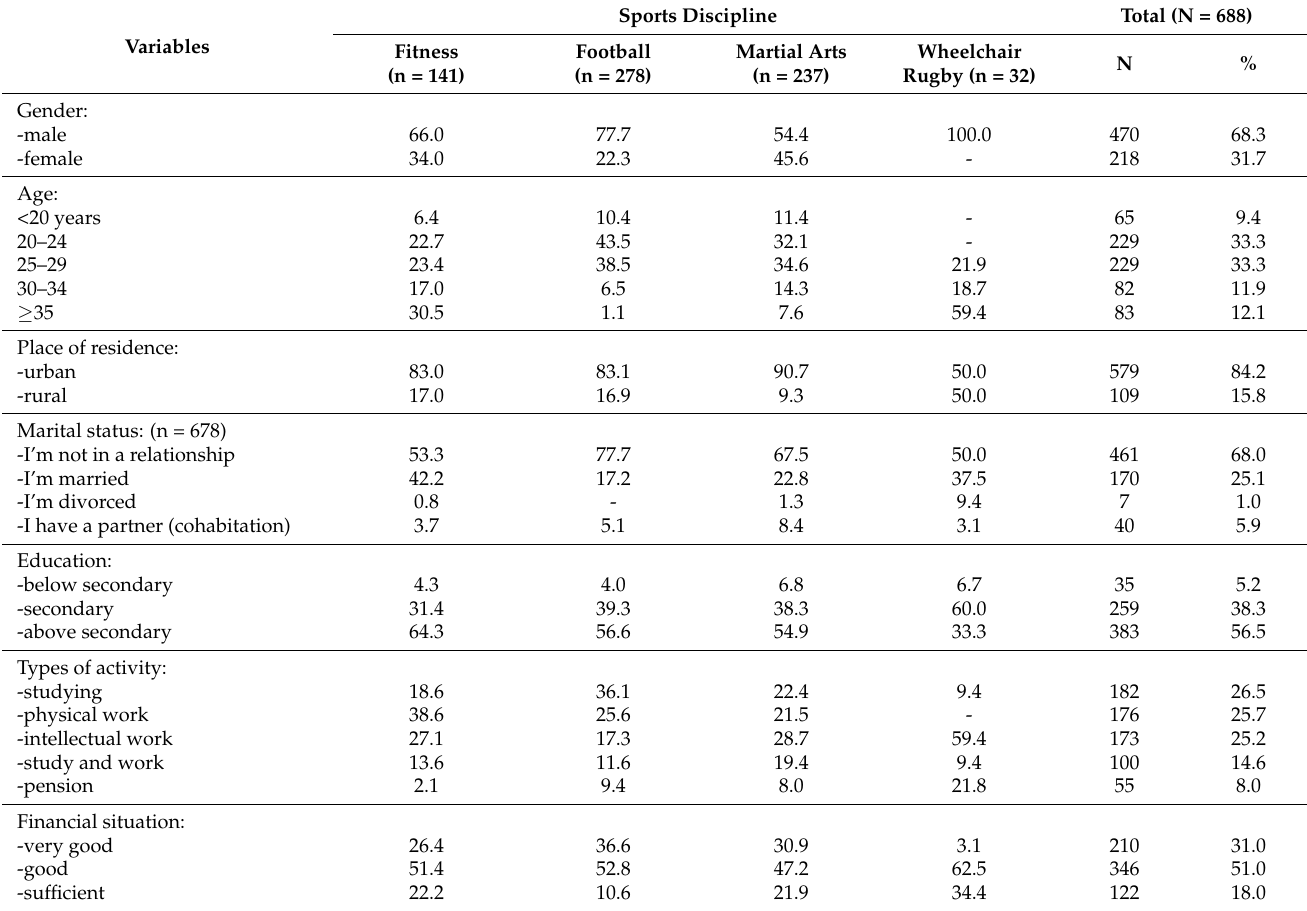
Table 1. Socio-economic characteristics of people practicing sports (n =